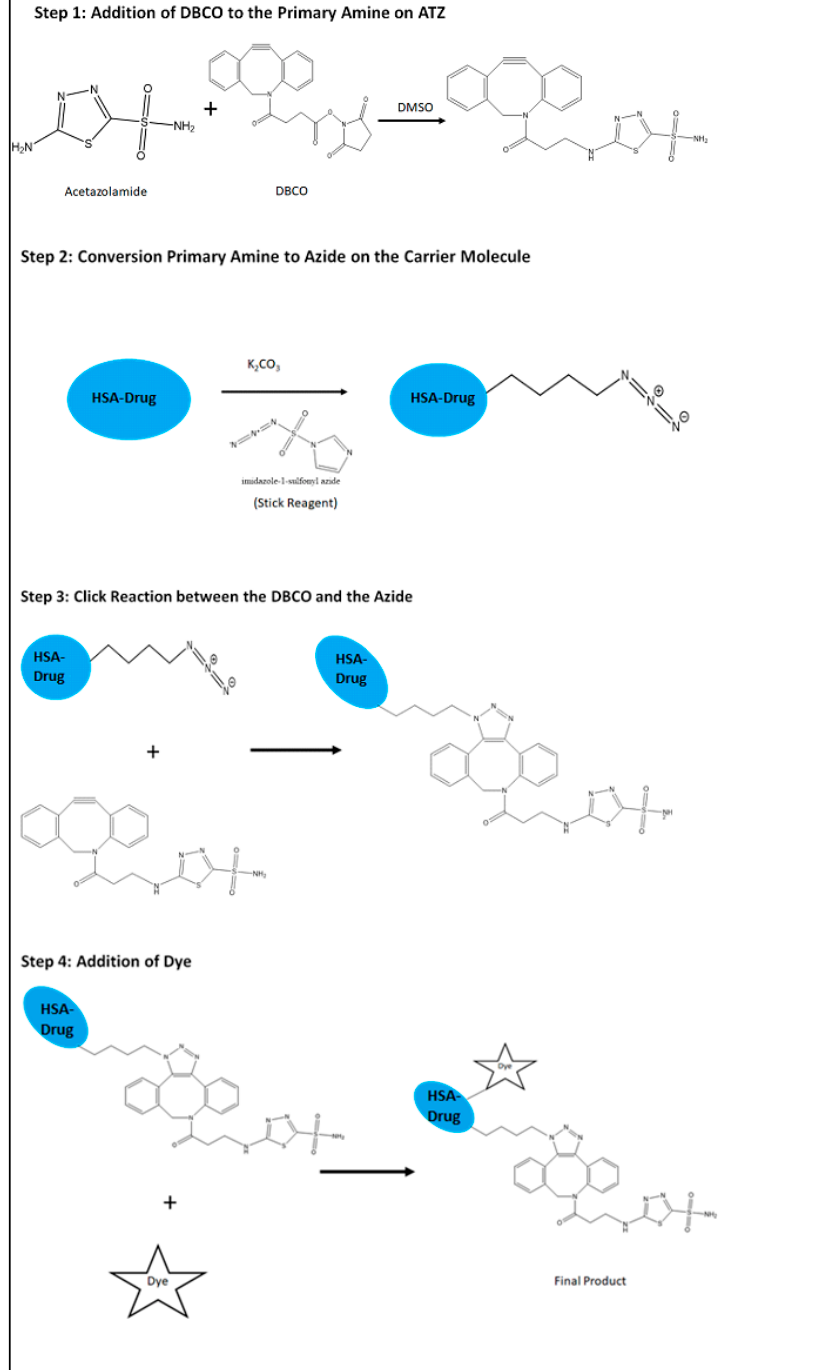
Figure 9. Schematic representation of the synthesis of the hypoxia targeting drug delivery system HSA-PTX-ATZ.